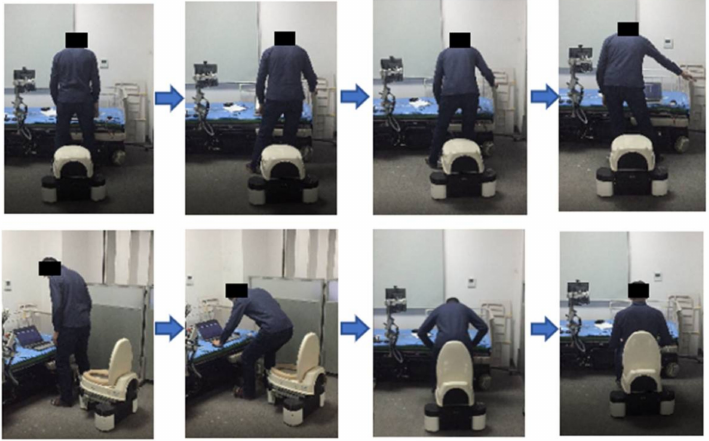
Figure 14. The robot-following experiment based on the analysis of the transfer position and